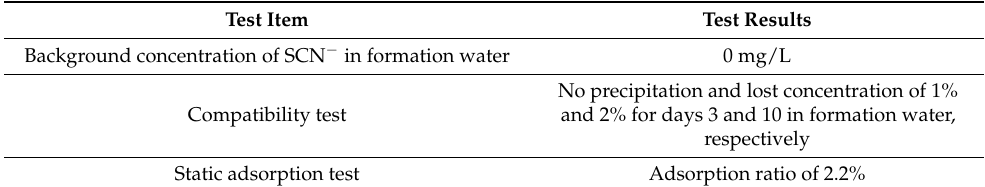
Table 2. Tracer evaluation results. Test Item Test